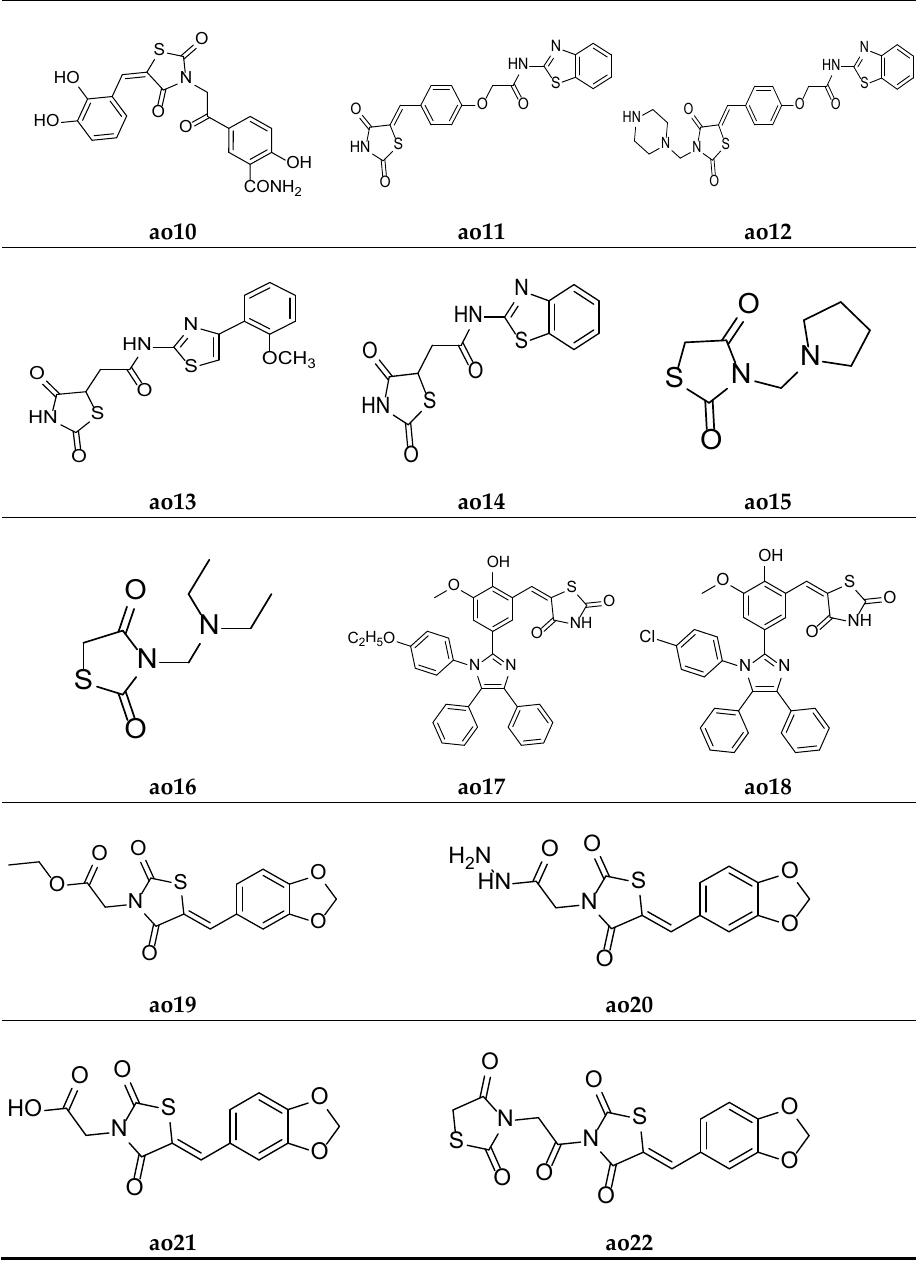
Figure 19. Molecular structures of the compounds ( ao10-ao22 ). Table 59. In vitro antioxidant activity of the synthesized compounds ( ao11 – ao12 ) using the DPPH scavenging